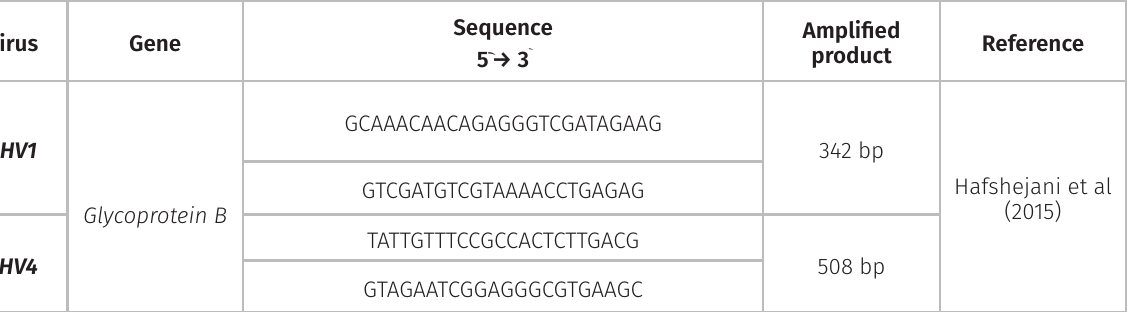
Table II. primers sequences Metabion®